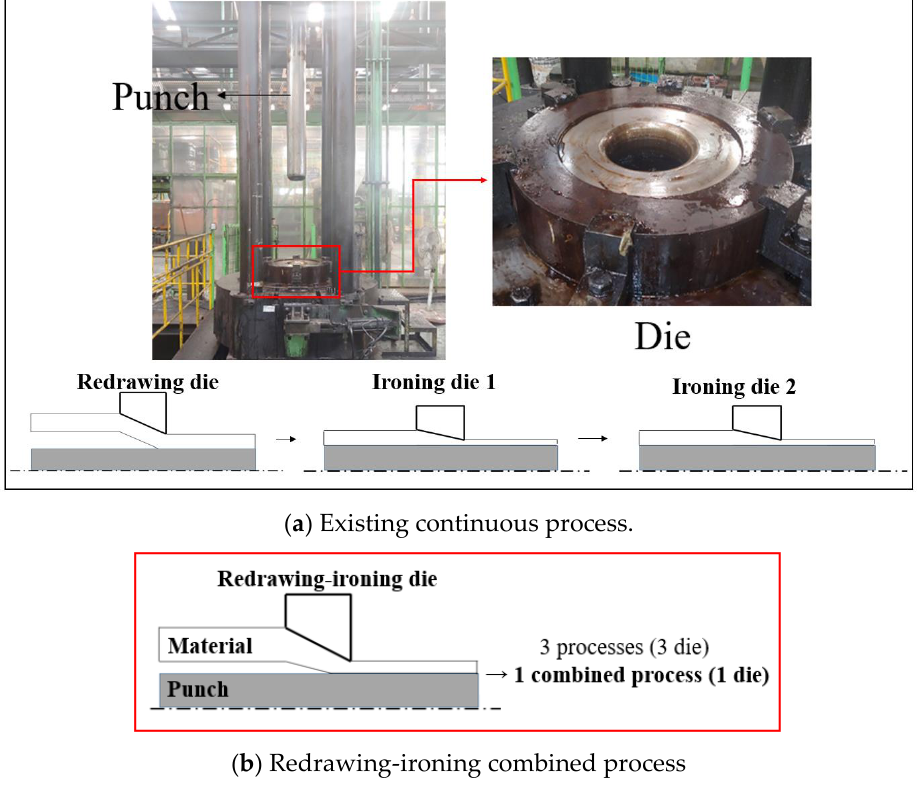
Figure 3. Comparison of the new combined redrawing-ironing process in 2nd stage with conven- tional one.